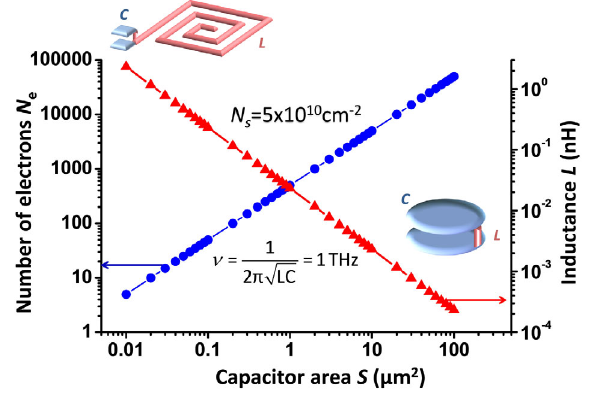
FIG. 3. Inductance L and total number of electrons in the system N e as a function of the capacitor surface S in the case where the resonant frequency is fixed at 1 THz and the areal density of electrons is fixed at N e =S ¼ 5 × 10 10 cm − 2 . The capacitor gap is d ¼ 80 nm and ε ¼ 12 . We have sketched possible geometries of the LC resonator in the cases where N 10 and N ≫ 1 e ¼ e